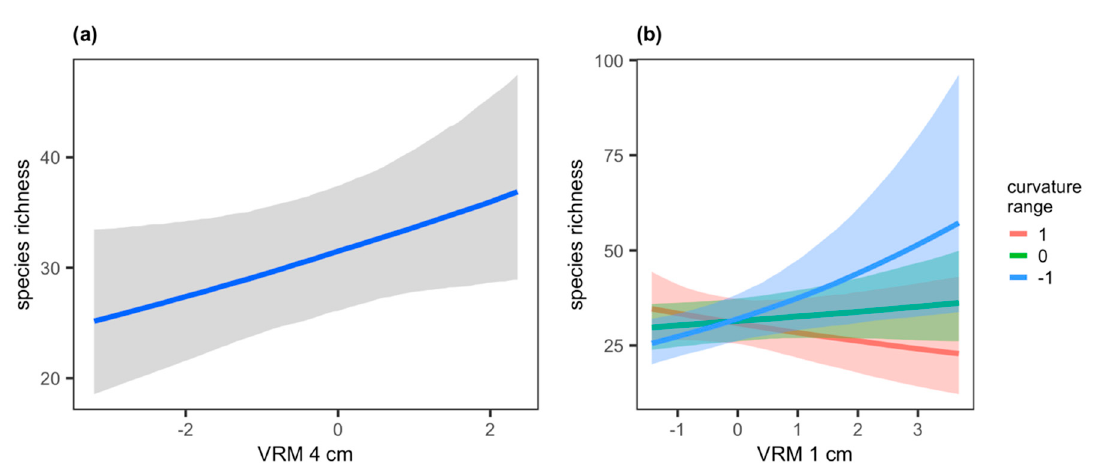
Figure 2. Conditional effect plots for ( a ) the standardized mean VRM deviation at 4-cm resolution and ( b ) the interaction between the standardized mean VRM at 1-cm resolution and the standardized curvature range showing the estimates of species richness per survey site.